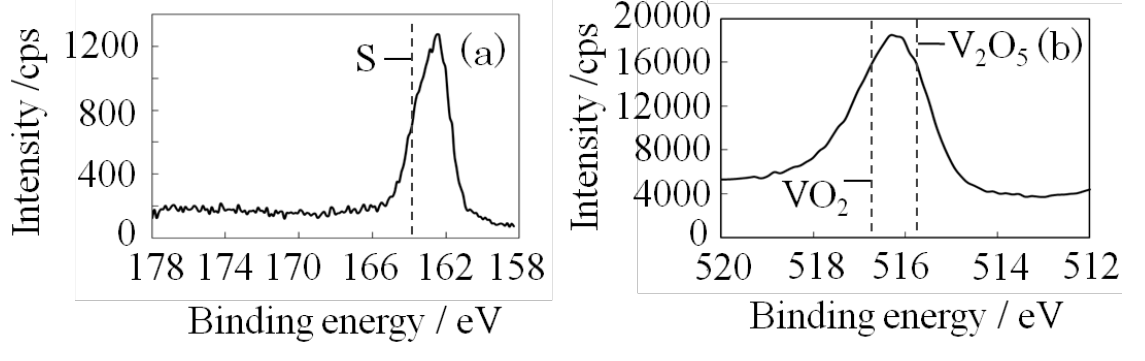
Figure 3. X-ray photoelectron spectroscopy (XPS) narrow spectra of S-V ( b ) V2p 3/2